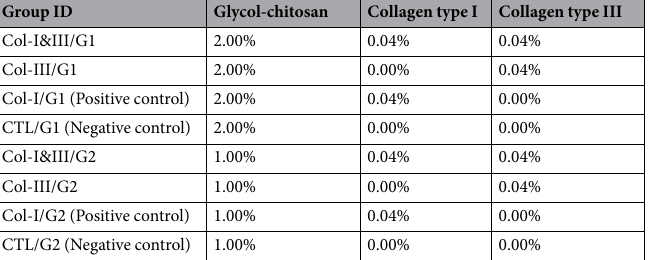
Table 1. Study groups with final concentrations of glycol-chitosan (GCS), collagen types I and III (Col-I: collagen type I, Col-III: collagen type III, Col-I&III: the simultaneous presence of Col-I and Col-III and CTL: negative control. G1 and G2 represent final GCS concentrations of 2% and 1% (GCS to collagen ratios of 50 and 25),